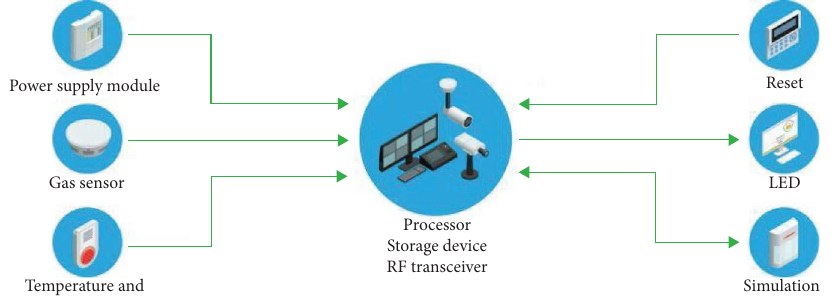
Figure 1: Block diagram of node